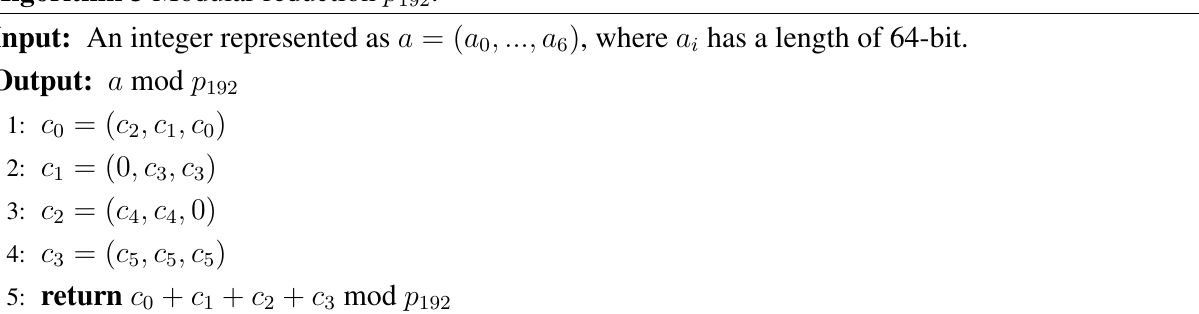
Algorithm 3 Modular reduction p